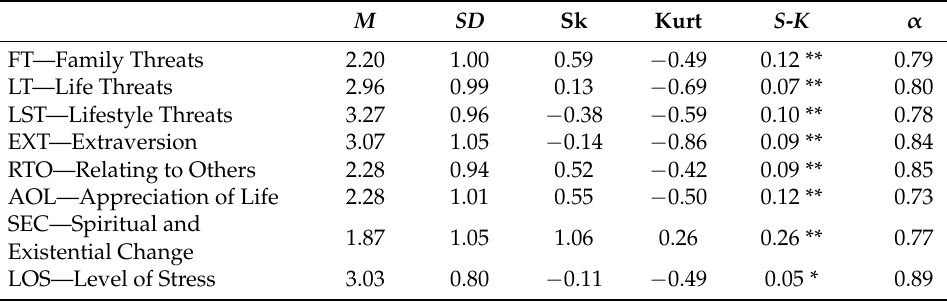
Table 1. Descriptive statistics of variables (N = 405).